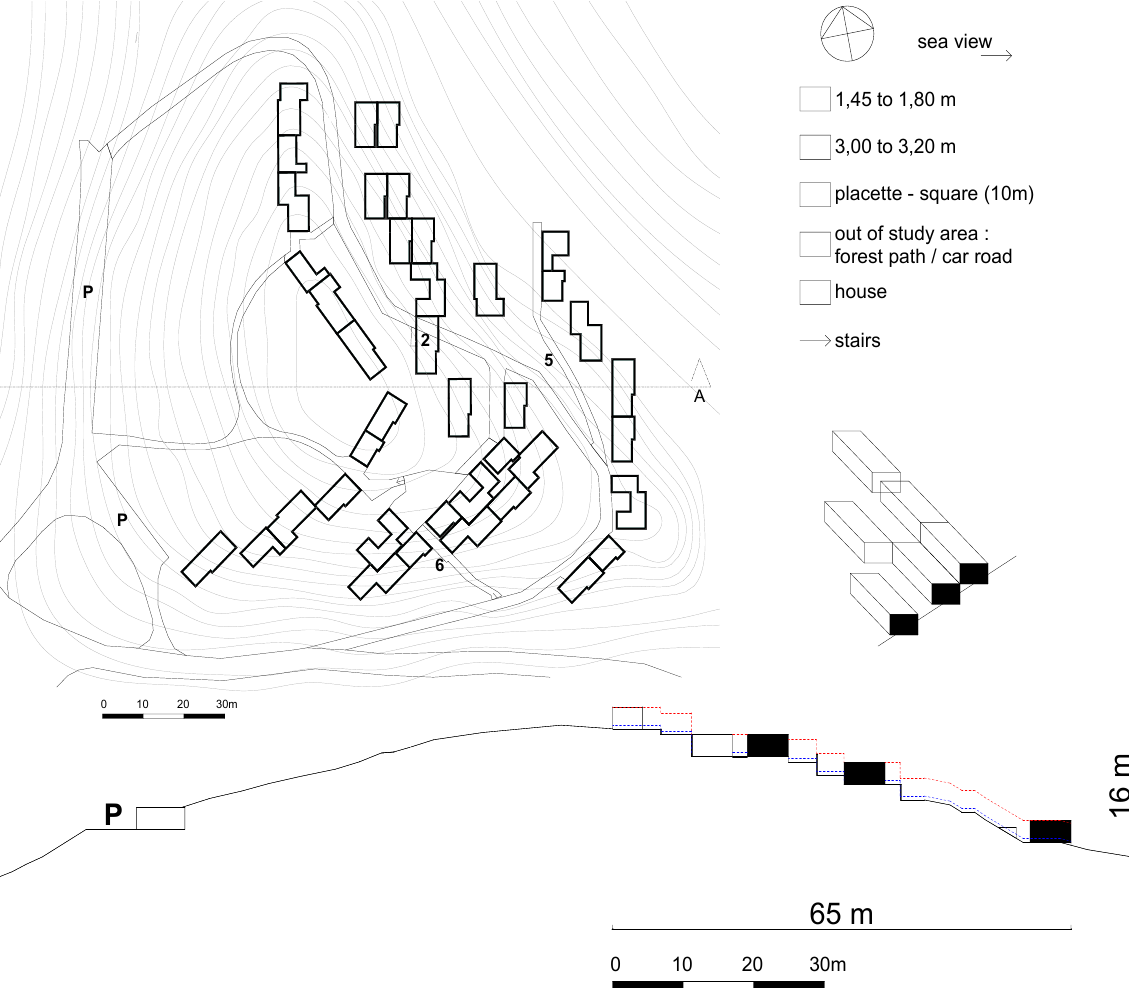
Figure 4. Gaou Bénat: Left: Ground floor plan with pedestrian street widths, slope contour lines, and SVF locations Right : schematic diagram of the strip assembly of units on a slope Bottom: Section A. Red line: mean building height; Blue line: Absolute Rugosity or mean urban canopy